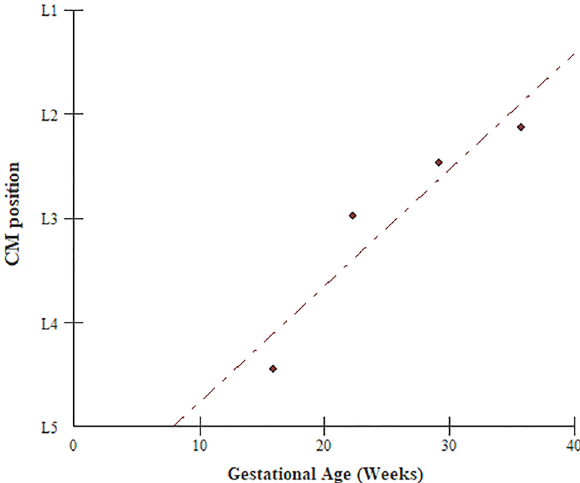
Figure 4. Correlation between gestational age and CM position.